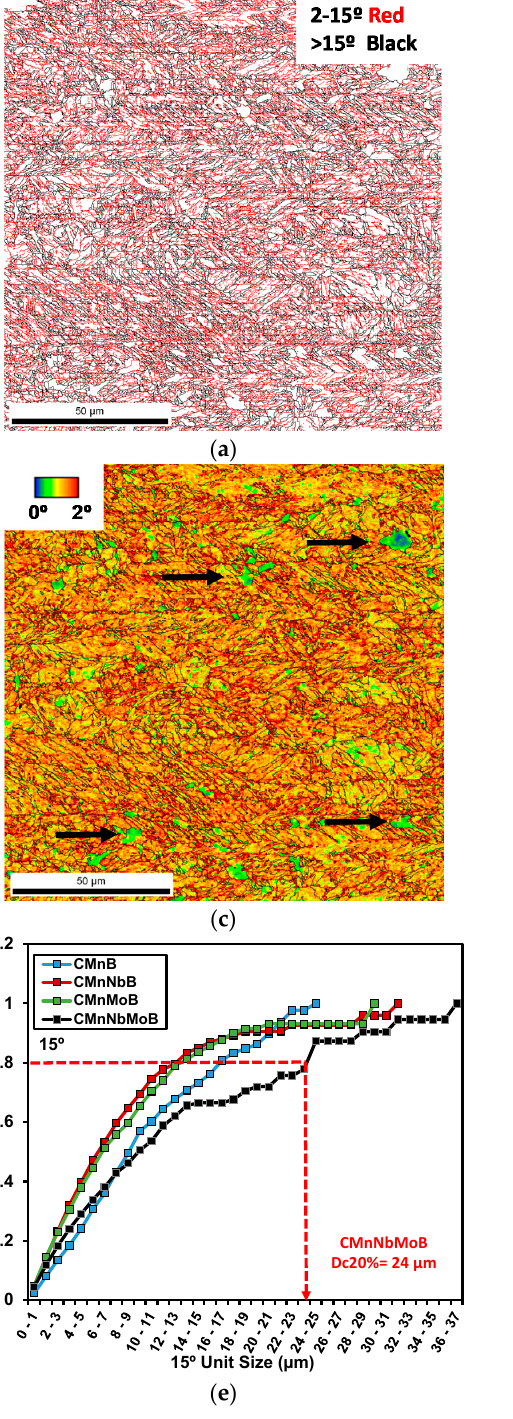
Figure 6. ( a , b ) Grain boundary maps and ( c , d ) Kernel maps corresponding to ( a , c ) Nb and ( b , d ) NbMo grades, ( e ) comparison between the unit size distributions taking into account 15° misorientation criteria and ( f ) D15° and Dc20%/D15° values measured for each steel grade.